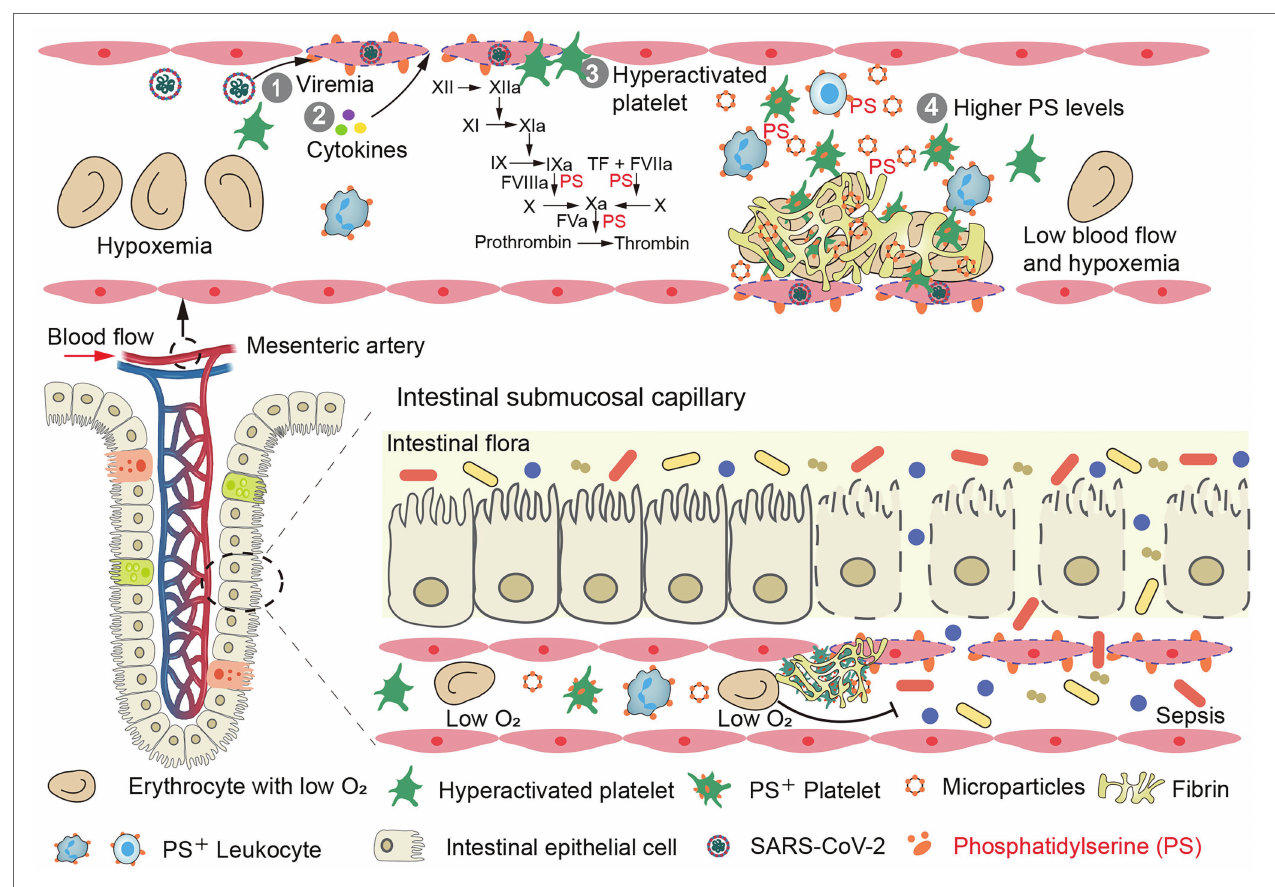
FIGURE 2 | Intestinal thrombosis leads to intestinal mucosal necrosis and dissemination of gut bacteria, endotoxins, and microbial metabolites in blood. (Top) Mesenteric vascular endotheliitis (initiated by viremia and accelerated by cytokines), hyperactivated platelets and high levels of phosphatidylserine (PS) promote a high rate of mesenteric thrombus in COVID-19 patients (mesenteric vein is shown in Supplementary Figure 1 ). (Bottom) Intestinal microthrombi and hypoxemia rapidly lead to intestinal mucosal ischemia and necrosis. The damaged gut–blood barrier leads to dissemination of gut bacteria, endotoxins, and microbial metabolites in